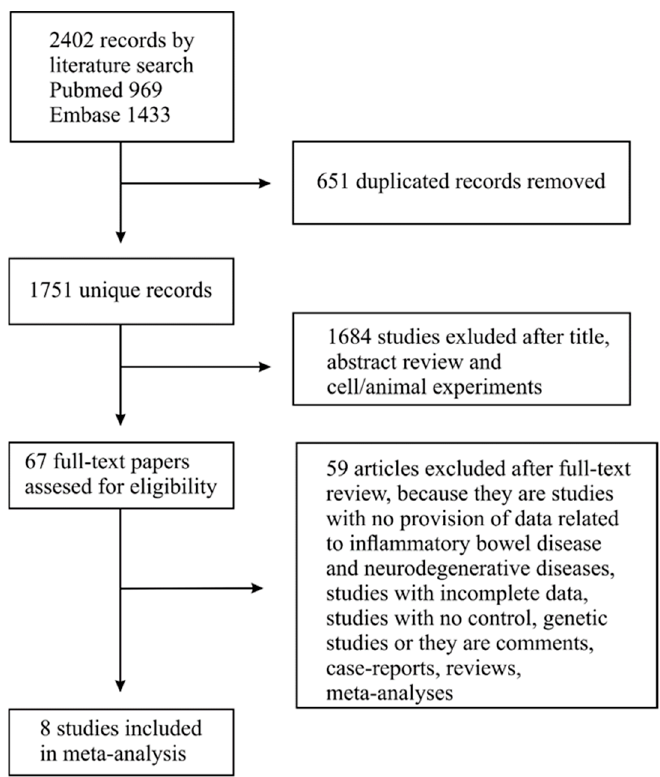
Figure 1. Flow diagram of the search process and study selection.